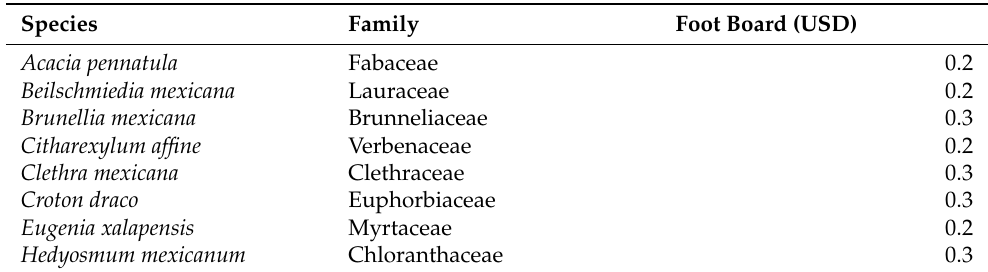
Table A3. Table Price of lumber timber from secondary cloud forest tree species in Mexico in 2019. Prices obtained from regional